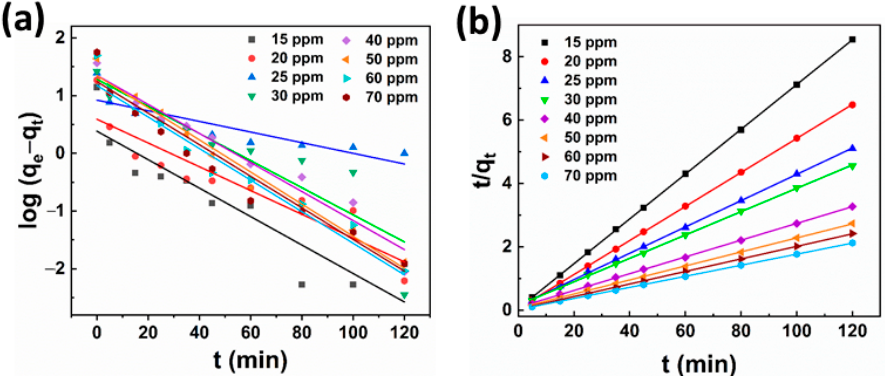
Figure 9. Fitting of adsorption data to ( a ) pseudo-first order model and ( b ) pseudo-second order